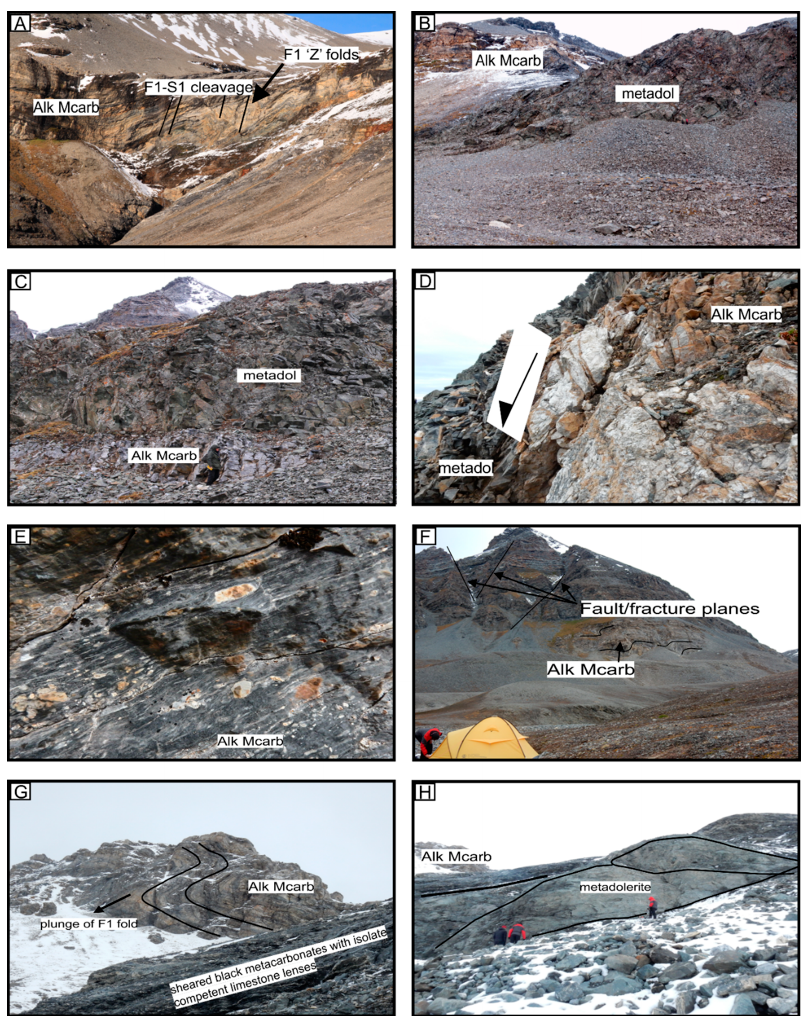
Figure 2. ( A ) Eastern flank of Daudmannsdalen showing F1 ‘z’ folds and S1 cleavage developed in the Alkhornet metacarbonates (Alk Mcarb) ( B ) Metadolerite (metadol) boudin at site DAUST2. intruded into Alkhornet metacarbonates. Boudin is cut by veral shear surfaces ( C ) Contact between Alkhornet metacarbonates and metadolerites. Bedding in the metacarbonates dips shallowly NW but steep fractures cut across the contact zone. Site DAUST3 ( D ) Metadolerite/carbonate contact zone with downfaulted dolerite (arrowed). Note the brecciation of the calcite veining in the late W dipping fault zone. Site DAUST3 ( E ) Metacarbonates just beneath the contact with the metadolerites are sheared with a top to the east shear sense. Site DAUST3 ( F ) Daudmannsdalen west flank minor ‘S’ geometry F1 folds indicating the upper limb of a west closing larger scale fold. Also note the west dipping and antithetic east dipping fault/fracture planes (arrowed). ( G ) Field view of PROST6 site the upper part of the photograph shows a N plunging ‘z’ fold in the Alkhornet metacarbonates. The underlying dark grey to black metacarbonates in the lower right of the view are the host rocks for the metadolerite shown in ( H ). The former, which are highly sheared, wrap around the metadolerite boudin and include, lenses of more competent limestones that represent isolated fold limbs. ( H ) Field view of PROST6 metadolerite sample site. Internally, the boudin is divided into smaller lenses (marked) that are cut by fracture/small scale fault planes. Above the boudin, top right, shows transitional facies from dark grey to Alkhornet-type metacarbonates.